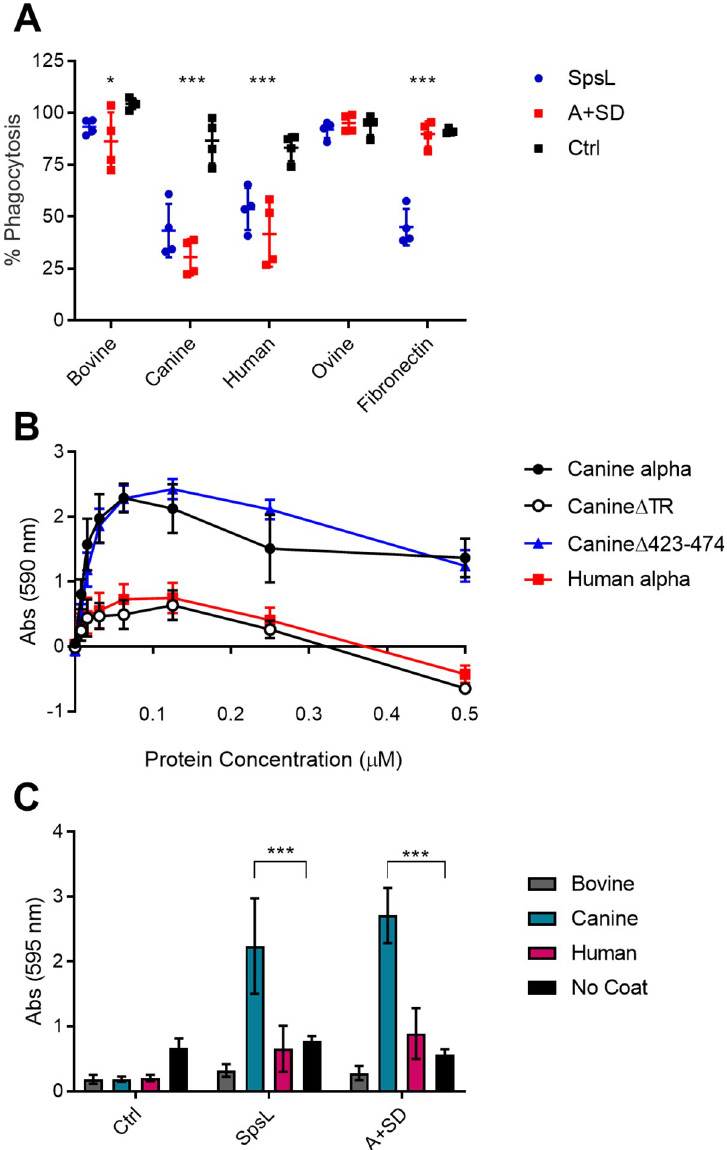
Fig 5. SpsL promotes evasion of neutrophil phagocytosis, bacterial aggregation and biofilm formation in a host- specific manner. (A) Differential phagocytosis of FITC-labelled bacteria expressing SpsL or A+SD opsonized with fibrinogen from bovine, canine, human, or ovine hosts or bovine fibronectin before being opsonized with 10% human serum. Data is presented as the percentage of cells containing phagocytosed bacteria in comparison to the serum-only control. Each data point represents the level of phagocytosis from neutrophils isolated from a single donor. Ctrl refers to bacteria containing an empty plasmid. The bar represents the mean and the error bars represent SD. Differences in phagocytosis were analyzed between all three bacterial groups for each opsonin (p � 0.05 or p � 0.001, one-way ANOVA). (B) Adherence of SpsL to canine fibrinogen α -chain in the presence of soluble purified peptides. Data points represent the mean ± SD (n = 9). (C) Biofilm formation by bacteria expressing SpsL or A+SD on surfaces coated with bovine, canine, or human fibrinogen. Error bars represent SD (p � 0.001, one-way ANOVA) (n = 4).